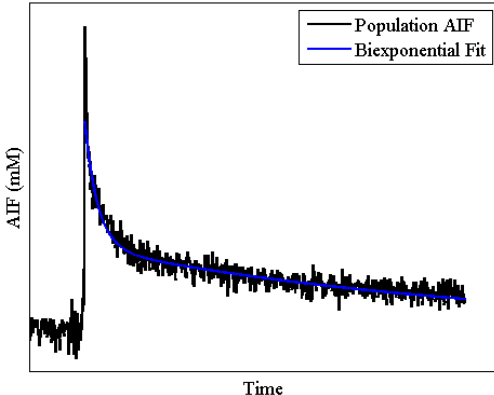
Figure 4. Typical AIF in a mouse system. The black line represents a population AIF obtained in mice. Notice the rapidness with which the peak occurs. The blue line shows a standard biexponential fit to the washout portion of the